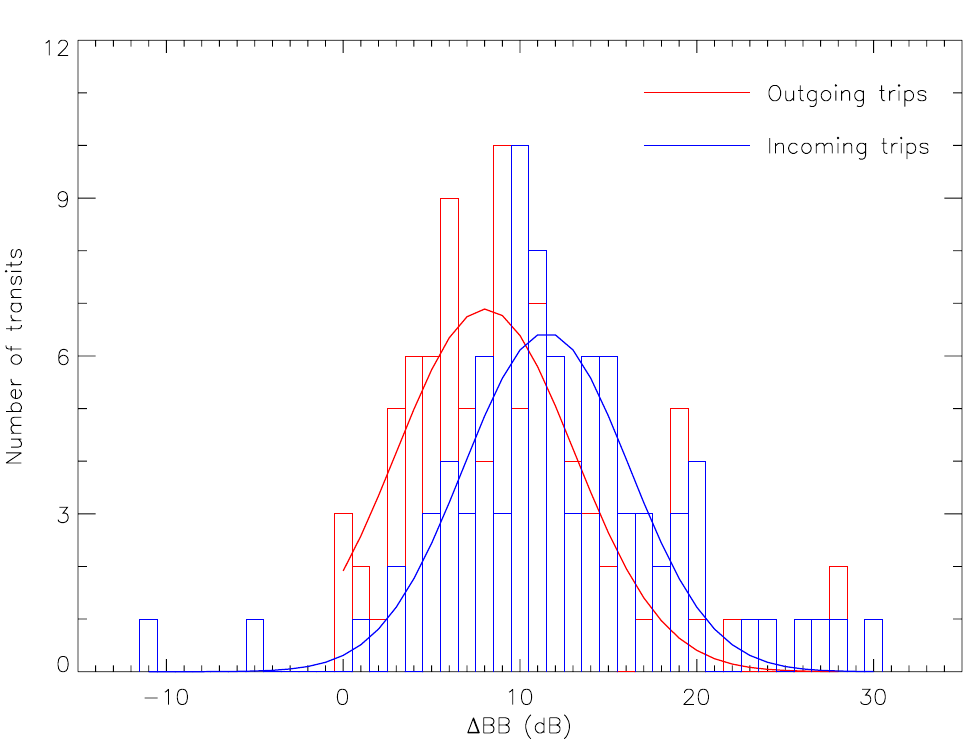
Figure 7. Histograms of BB acc MSL [ f 0 − f 1 ] - BB CPA MSL [ f 0 − f 1 ] according to the data listed in Table 5. Outgoing (in red) and incoming (in blue) ships are treated separately. Solid lines are the corresponding normal distributions fitted on each